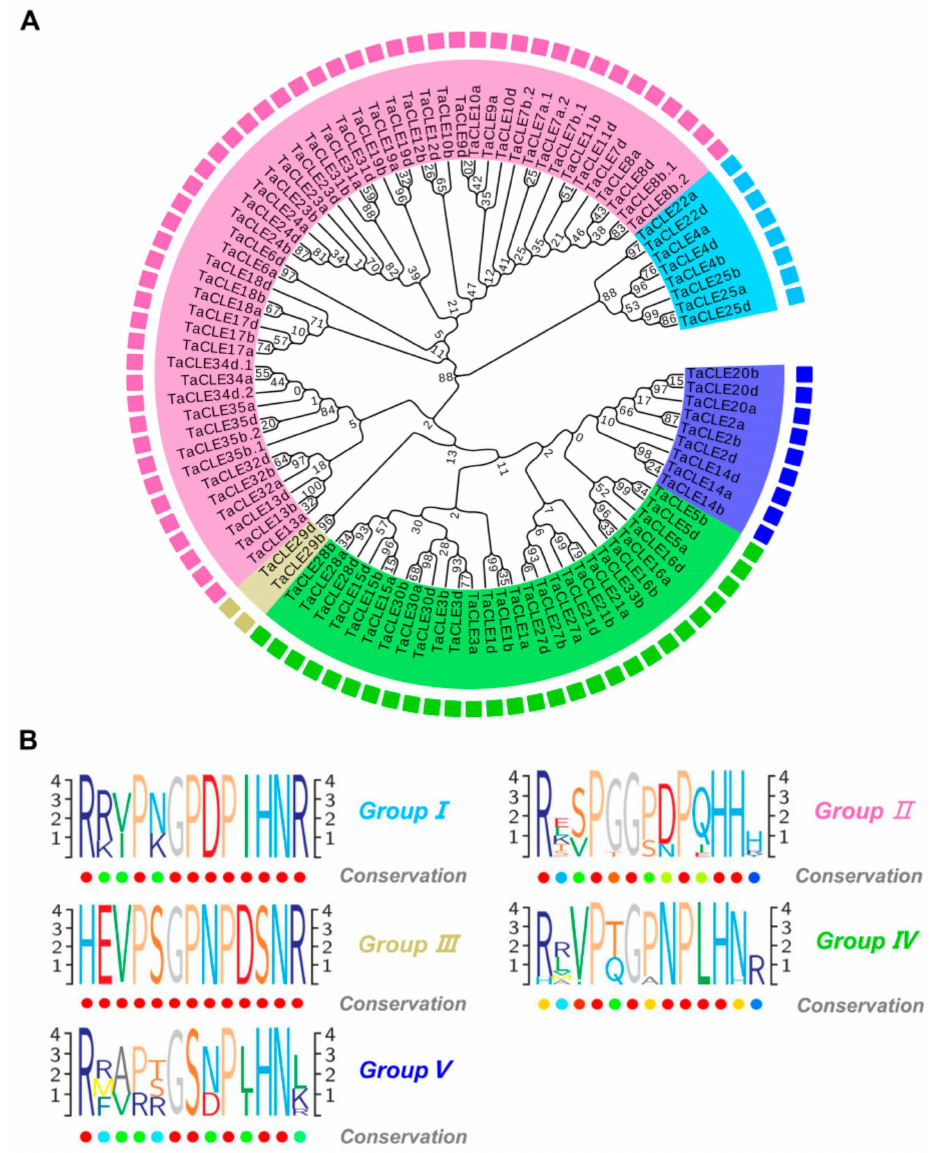
Figure 1. Wheat CLAVATA3 / EMBRYO SURROUNDING (CLE) pre-propeptide phylogenetic tree illustrating the five distinct identity groups. ( A ) Phylogenetic analysis was performed using the multiple sequence alignment generated with entire pre-propeptide sequences. Homologous genes consistently clustered together with high confidence (indicated by high bootstrap values). The five groups (Group I–V) were assigned based on clustering in the tree, in addition to sequence similarity. The tree is shown with bootstrap confidence values expressed as a percentage based on 1000 bootstrap replications. ( B ) The CLE domain consensus sequences from the seven wheat pre-propeptide groups. Logo diagrams illustrate the 13 amino acid CLE domain consensus sequences for wheat CLE Groups I–V, determined from multiple sequence alignments generated for each